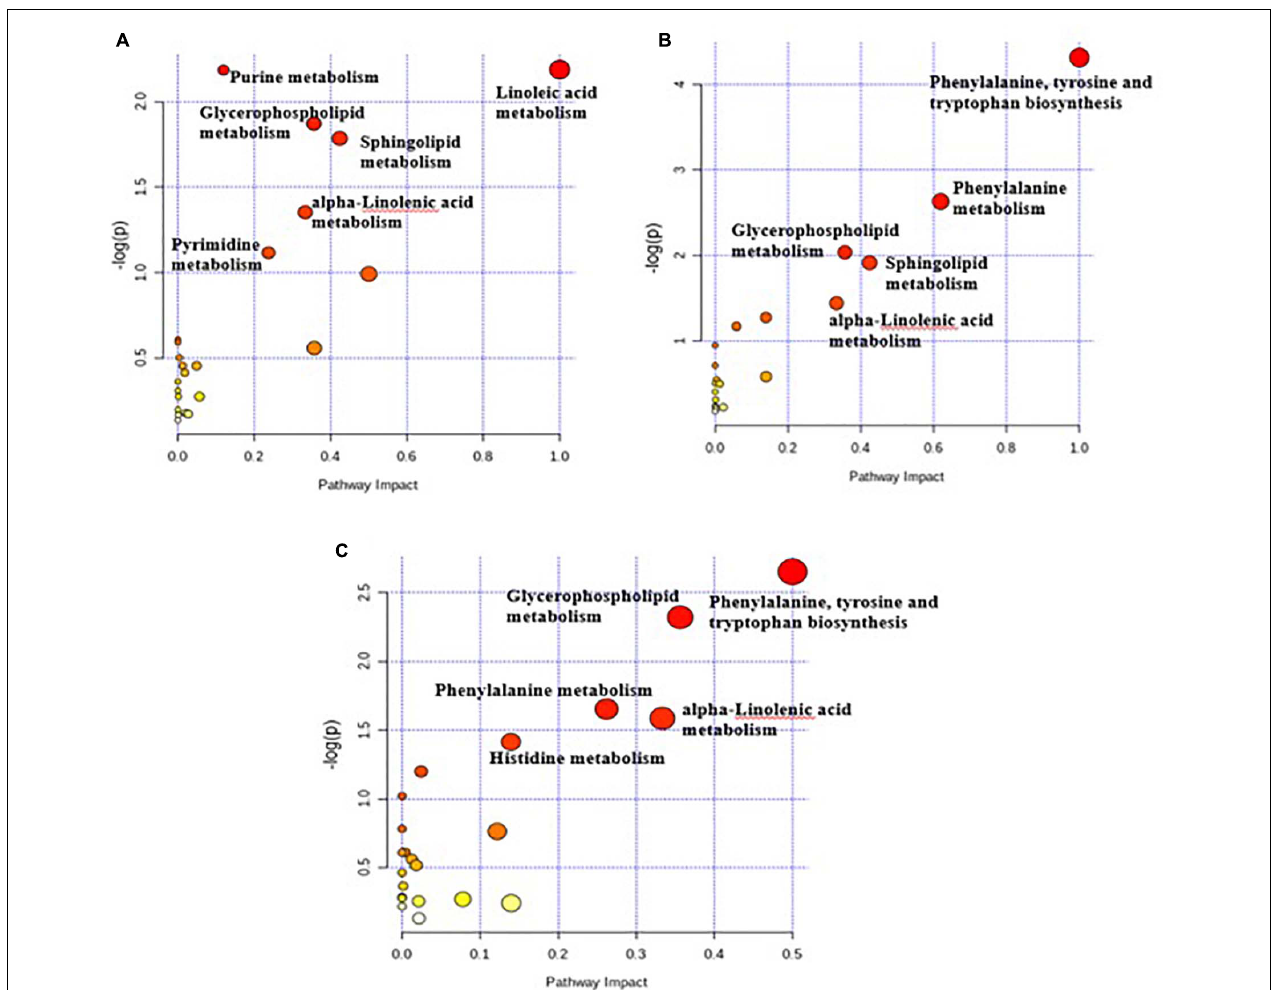
FIGURE 4 | Pathway impact resulting from the differential ruminal metabolites based on Bos taurus KEGG database using MetaboAnalyst 4.0. The X-axis represents pathway impact and the Y-axis represents the pathway enrichment. The larger size of the circle indicates greater pathway enrichment and the darker color indicates higher pathway impact values. The closer the color is to red, the smaller the p -value is. (A) Metabolome view map of metabolites between C and G3 yaks; (B) metabolome view map of metabolites between C and G6 yaks; (C) metabolome view map of metabolites between G3 and G6